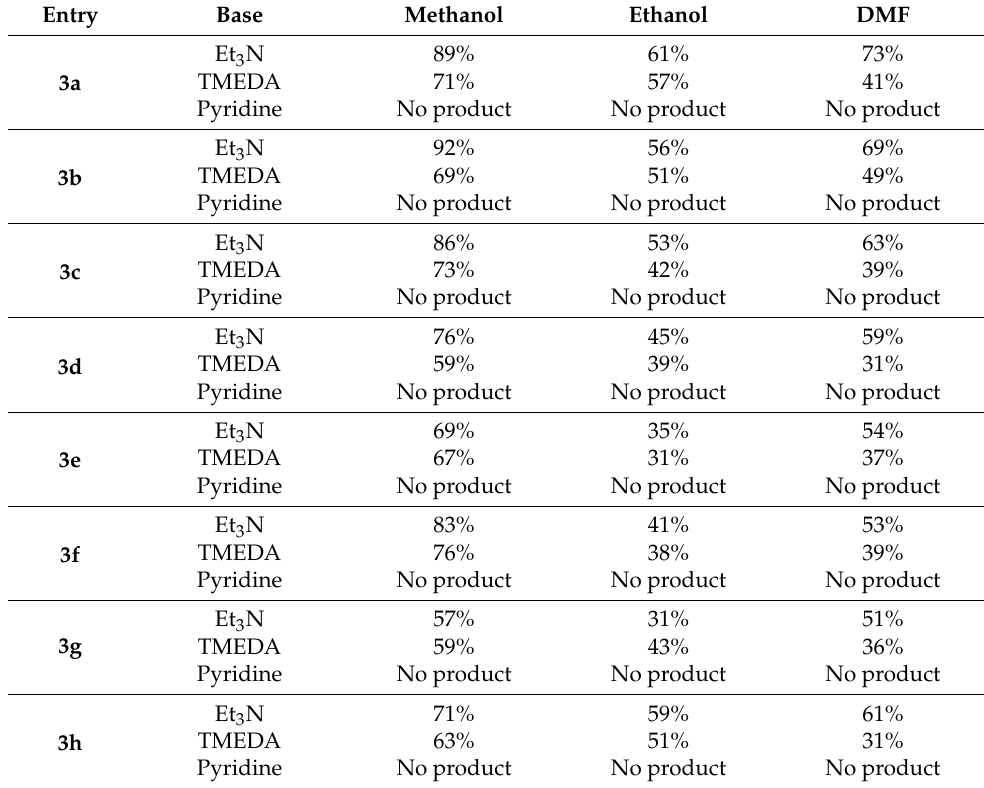
Table 1. Effect of solvent on yield of compounds 3a – 3f by using Cu(OAc) 2, Et 3 N, and TMEDA. Entry Base